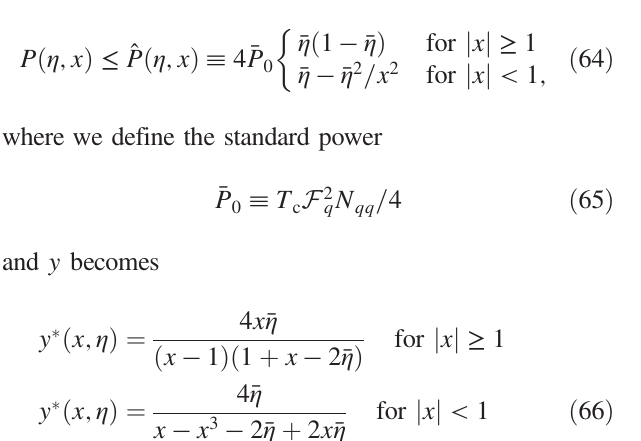
FIG. 3. Operation cycle of a Brownian heat engine. The vertical axis corresponds to the normalized time-dependent strength of the harmonic trap in units of ℘ ≡ κ ð t Þ = κ 0 , the horizontal axis to the normalized width V ≡ h x 2 i = ð 2 x 2 0 Þ of the distribution function. This plot is analogous to the pressure volume diagram of a macroscopic heat engine such that the area encircled by the colored lines quantifies the work extracted per operation cycle. Specifically, the plots were obtained using the protocols (73) and (80) for different values of the shape parameter d , 2 μκ 0 T ¼ 1 , η F 1 = 10 and ¯ η ¼ 1 = 2 . The small graphics show T q ¼ C ¼ c sketches of the potential (gray line) and the phase-space dis- tribution, whose color reflects the temperature of the heat bath, at the respective edges of the cycle. For further explanations, see Sec.